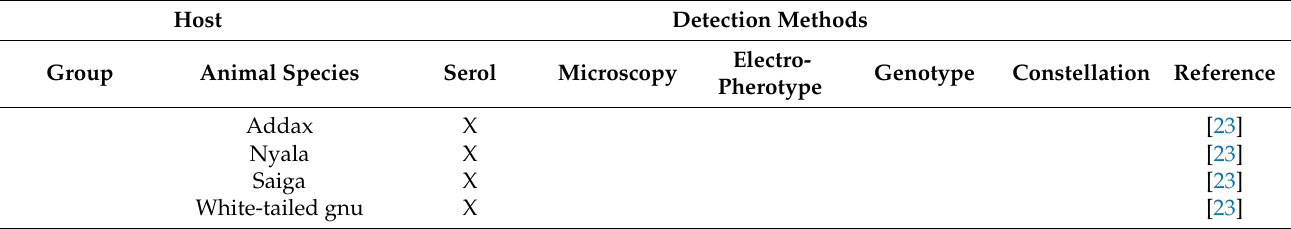
Table A1. RVA hosts and detection